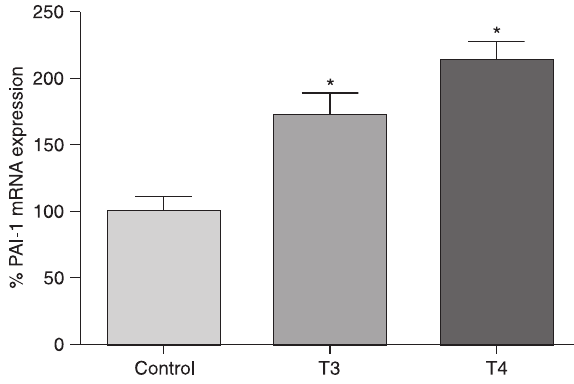
Figure 1. PAI-1 gene expression by 3T3-L1 adipocytes treated for 24 h with T4 or T3 (N = 12/group). Data (means ± SEM) are